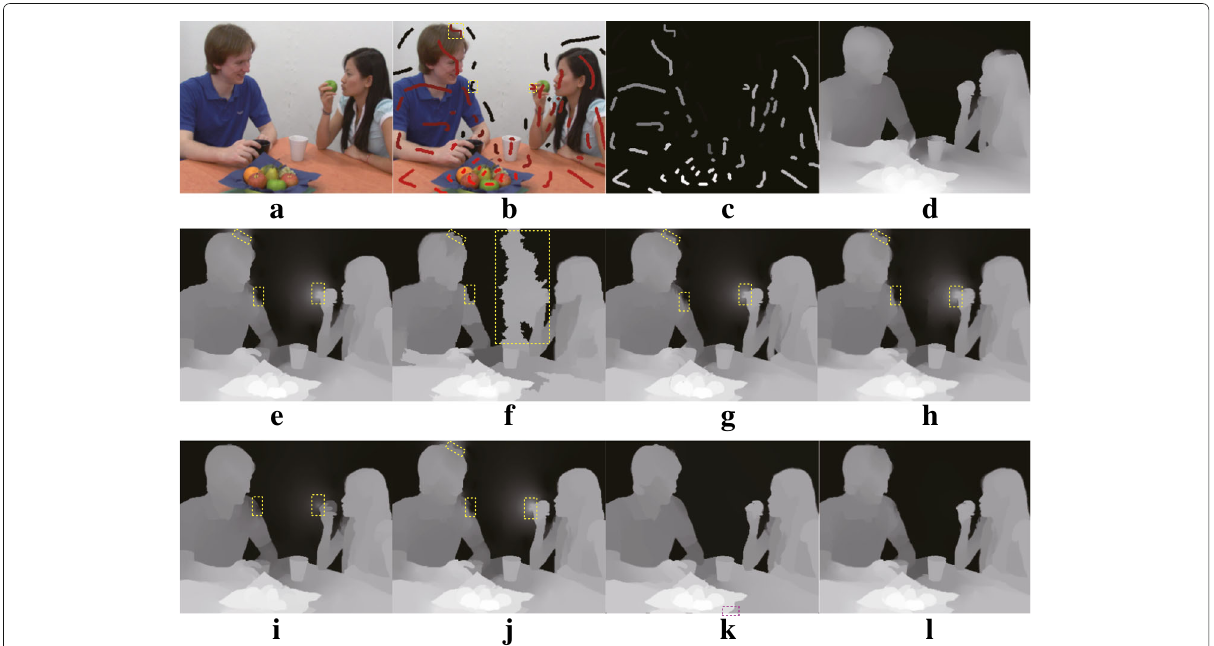
Fig. 4 Results of RGBZ_01 with cross-boundary input. a Input image. b User-labeled image. c Sparse depth. d Groundtruth depth. e Depth of RW. f Depth of HGR. g Depth of NRW. h Depth of OPT. i Depth of OCP. j Depth of SDF. k Depth of (cid:2) 1 . l Depth of the proposed method. Please zoom in to see details